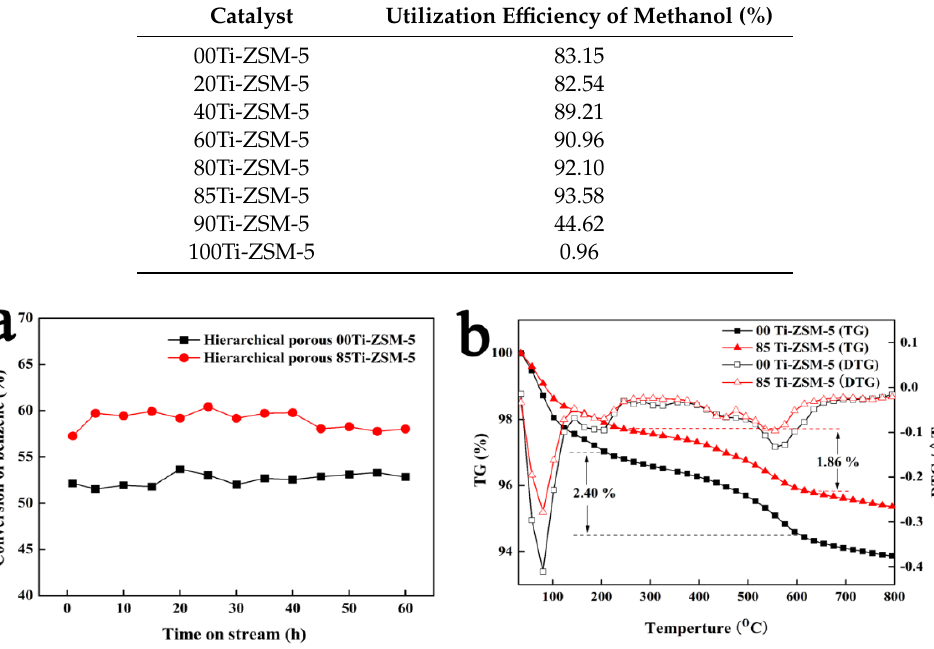
Table 5. Utilization e ffi ciency of methanol of hierarchical porous Ti-ZSM-5 catalysts. Catalyst